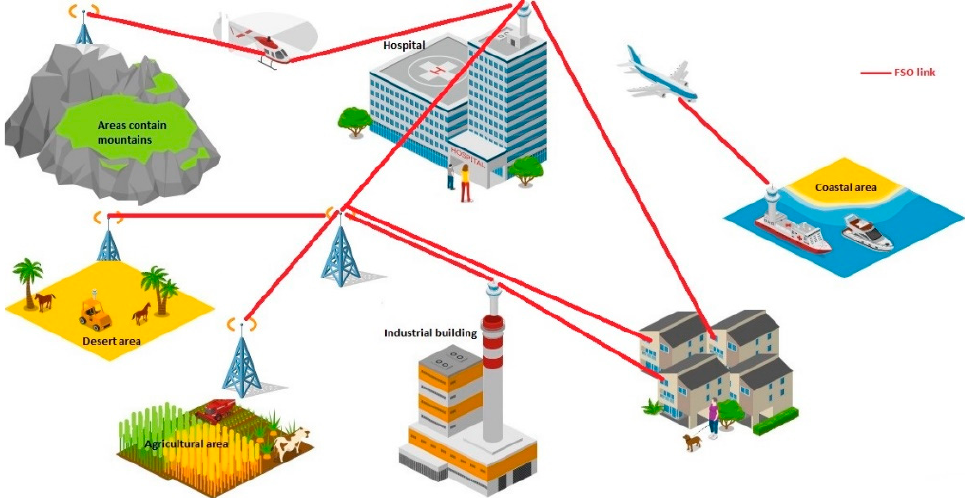
Figure 1. Different areas where FSO link can be applied for 5G and beyond